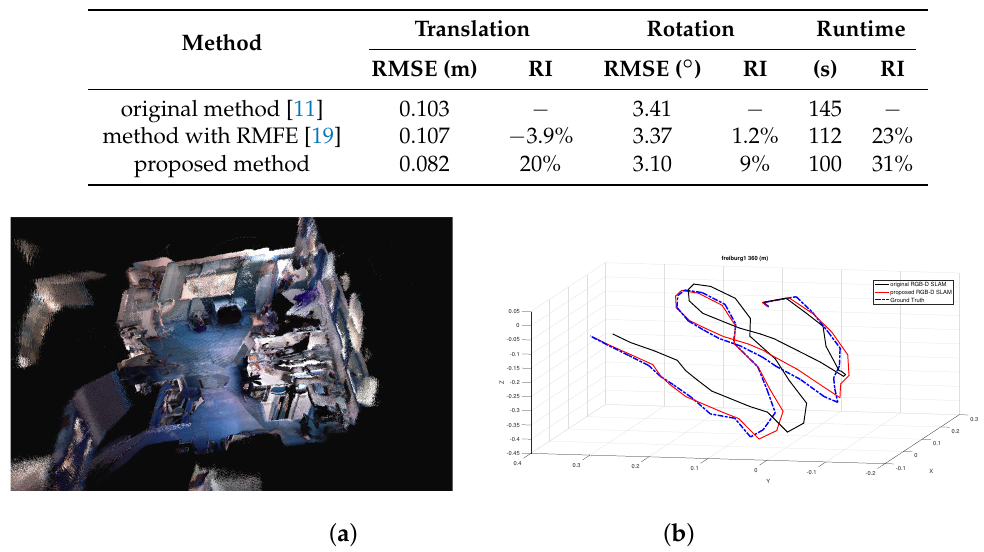
Figure 2. Experimental results of the proposed RGB-D SLAM with sequence fr1/360. ( a ) Mapping results in the form of volumetric 3D model. ( b ) Estimated trajectories.